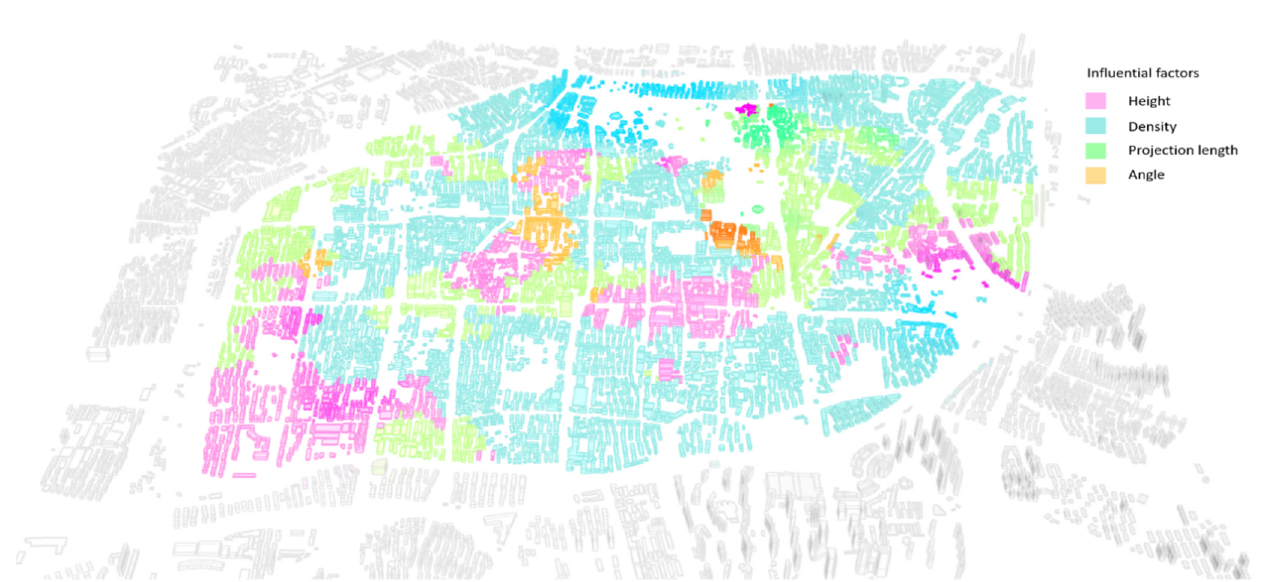
Figure 6. Influential areas and relative intervention methods: ( a ) density method; ( b ) height method; ( c ) projection length method; ( d ) orientation of the viewpoints direction method.